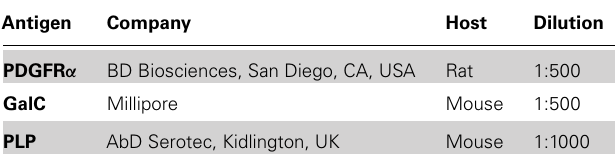
Table 1 | Primary antibodies used for